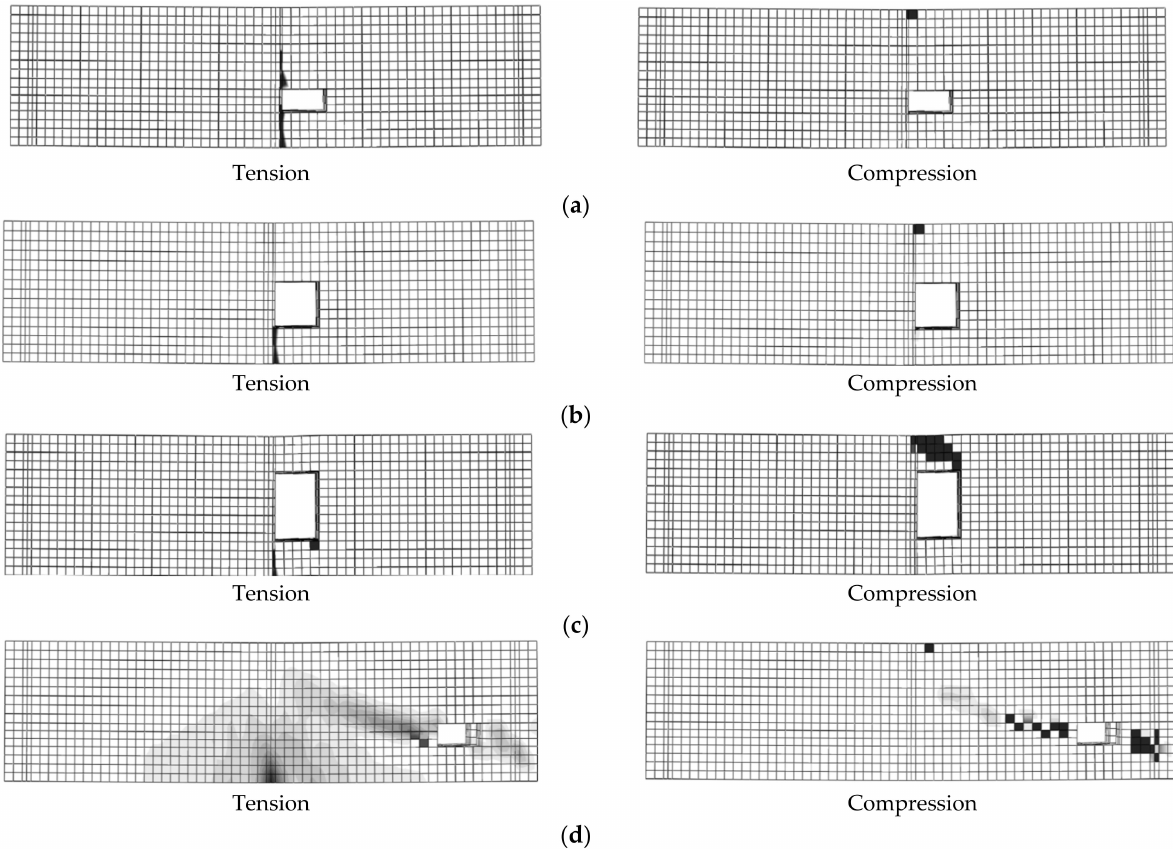
Figure 11. Failure modes of some beams listed in groups 4 and 5: ( a ) Beam B8-1; ( b ) Beam B8-2; ( c ) Beam B8-3; ( d ) Beam